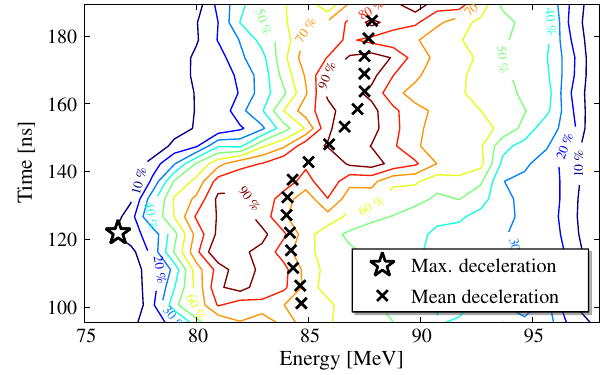
FIG. 10. Measured energy spectrum along the pulse at the end of the TBL, for 21.4 A beam current. The contour lines show 10% increments of the maximum value of the signal, and there is a step in the measured energy because of a change in the form factor. The star shows the point with the most decelerated particles, while the crosses show the mean energies.